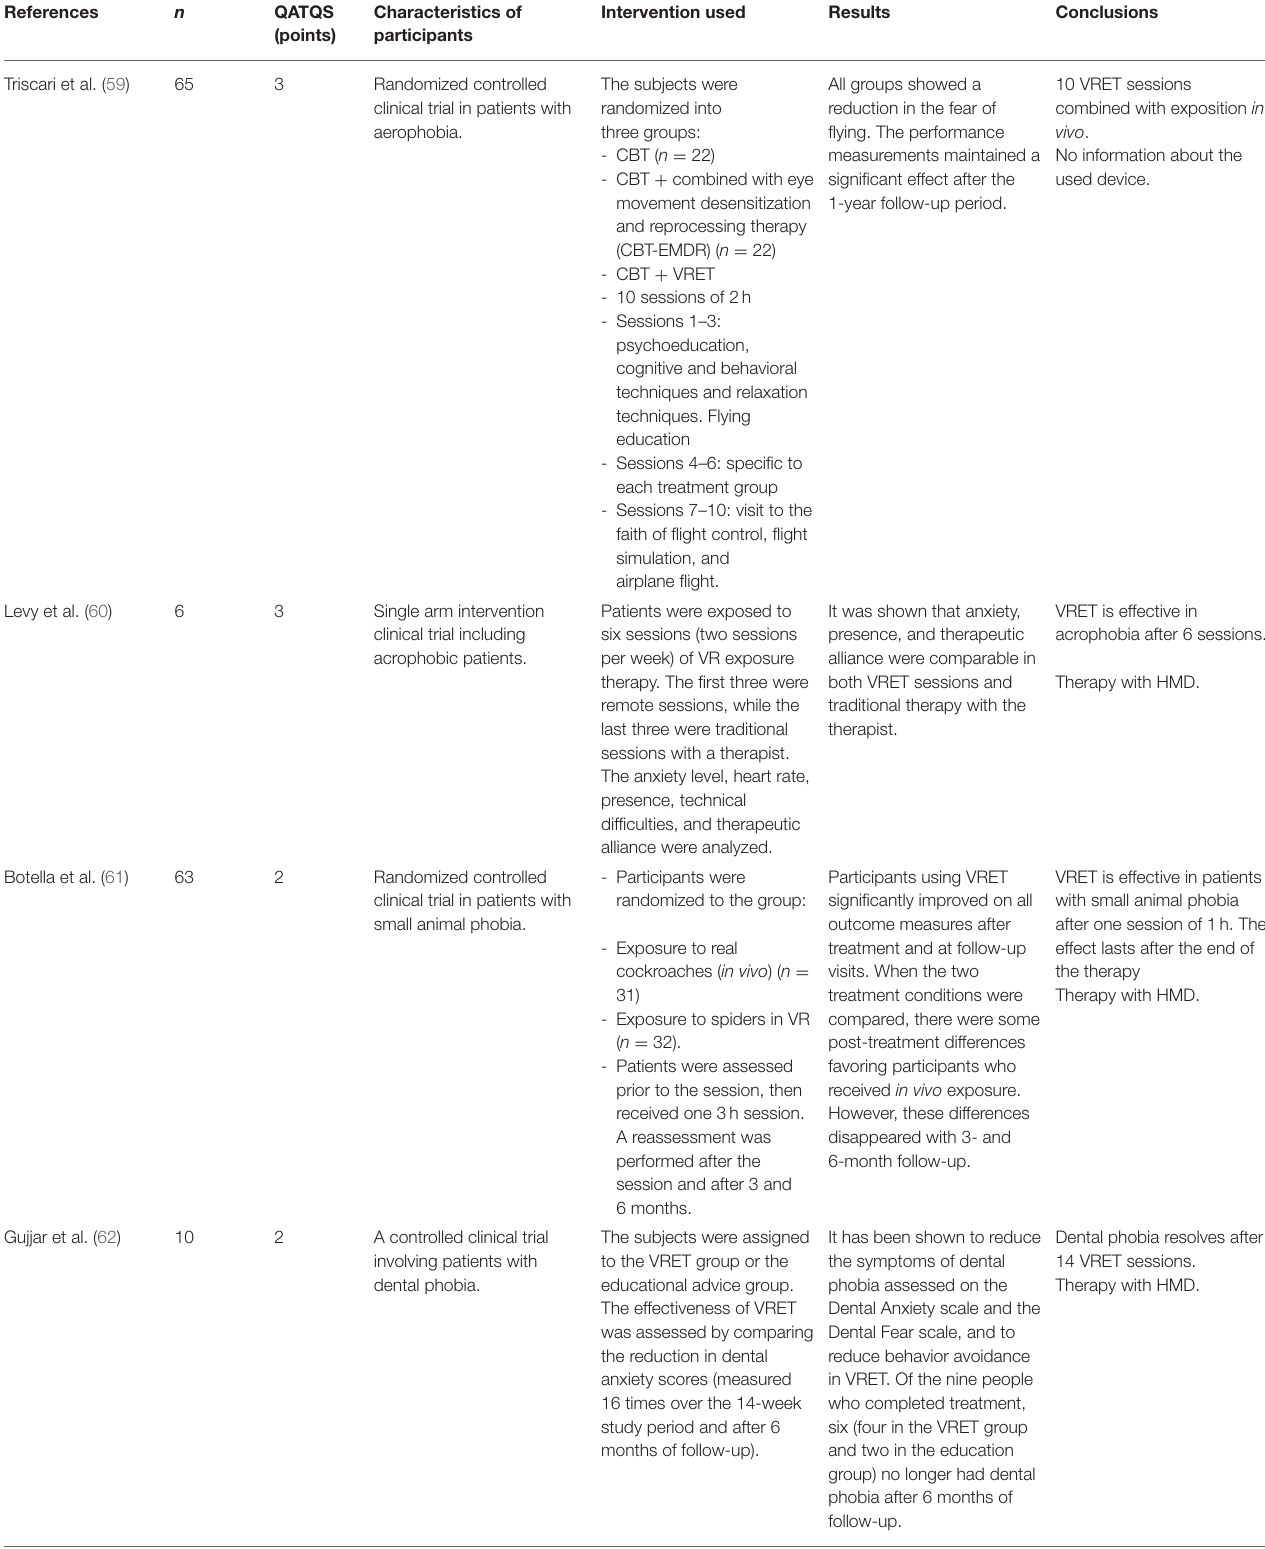
TABLE 3 | Studies on the use of VR exposure therapy in specific